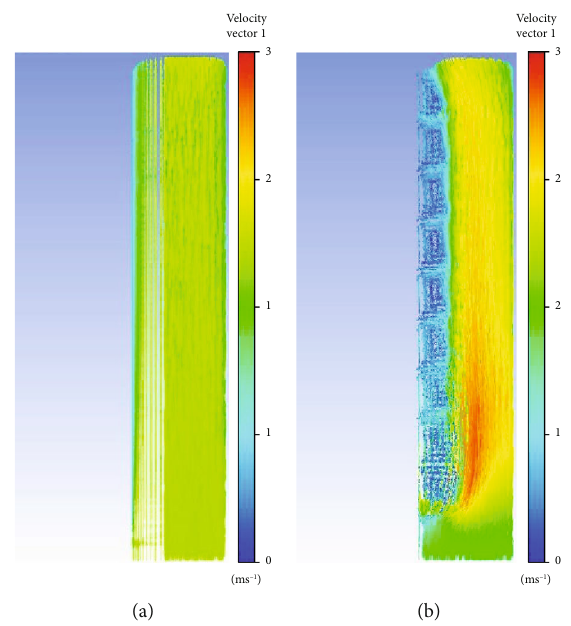
Figure 5: Velocity vector of a PV panel (a) without and (b) with aluminum heat